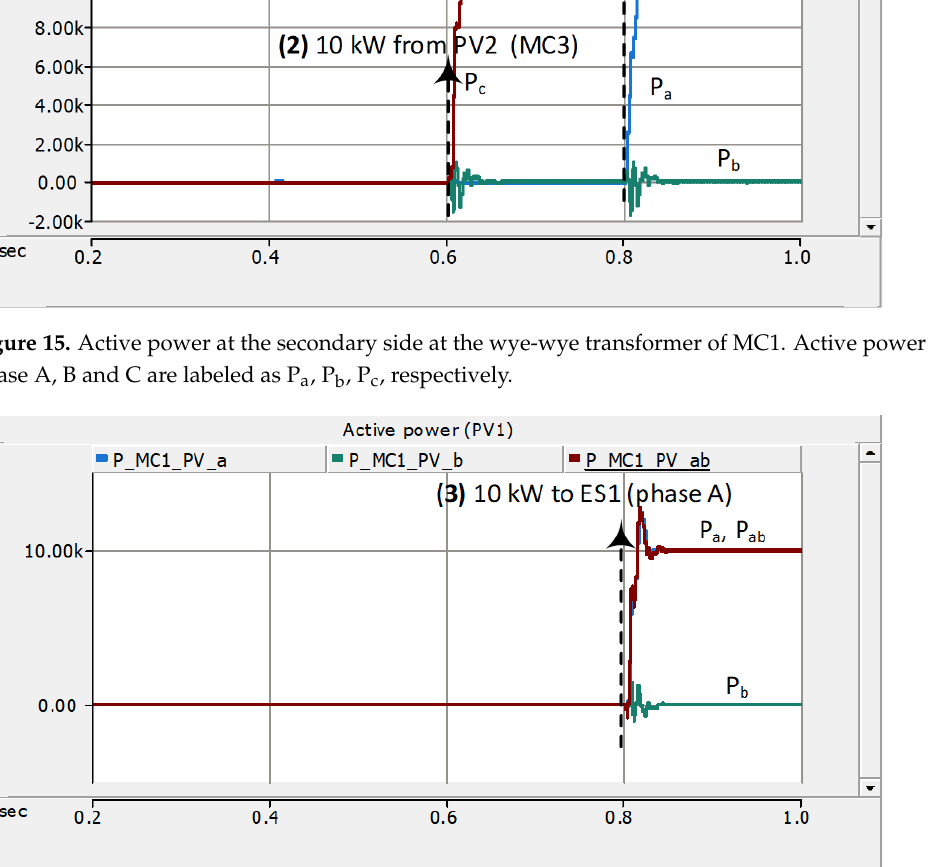
Figure 16. Active power of PV1 in MC1. Active power injection to phase A, B, and total power are labeled as P a , P b , P ab ,